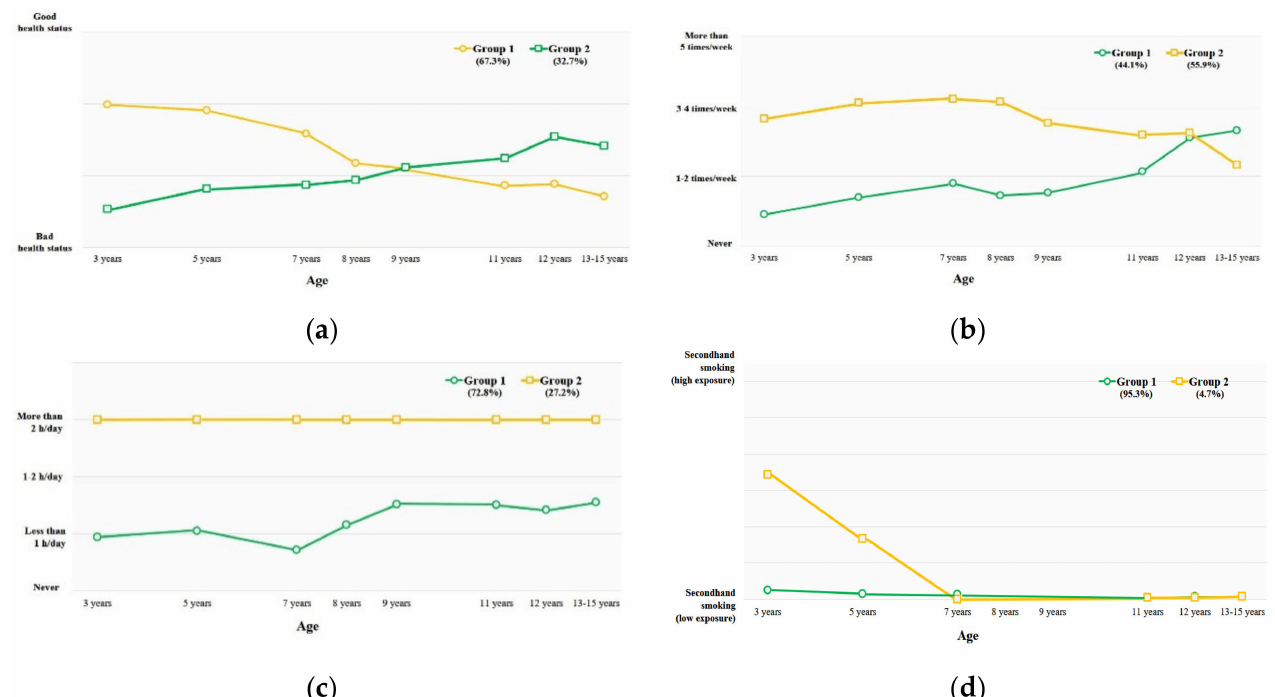
Figure 1. Trajectories of health-related behaviors from 3 to 15 years of age: ( a , Subjective